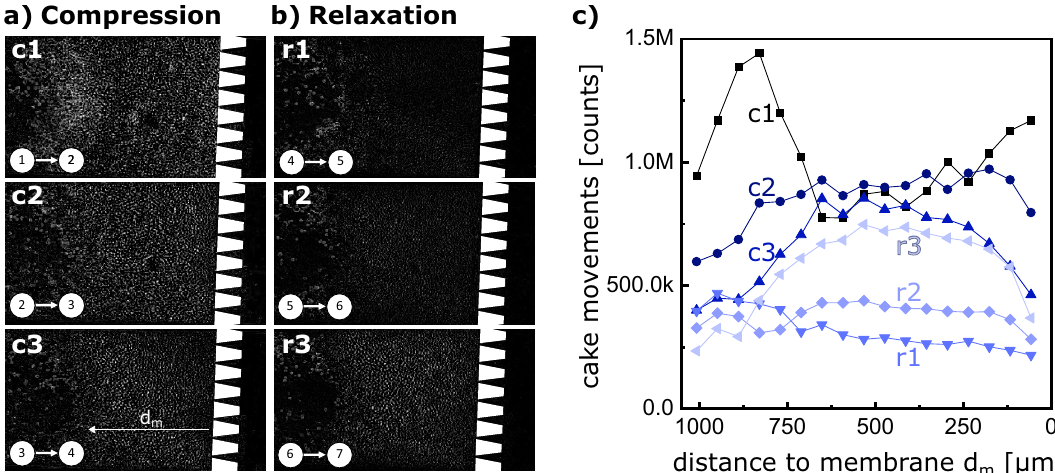
Figure 3. Spacial resolution of the pressure stepping cake mobility. Compression ( a ) and relaxation ( b ) heat maps revealing cake movements during the pressure stepping experiment from Fig. 2 uncompressed. Heat map comparison illustrating spacial resolution of cake movements at different compression and relaxation steps ( c